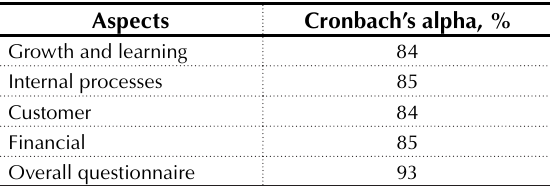
Table 1. Questionnaire aspects alpha